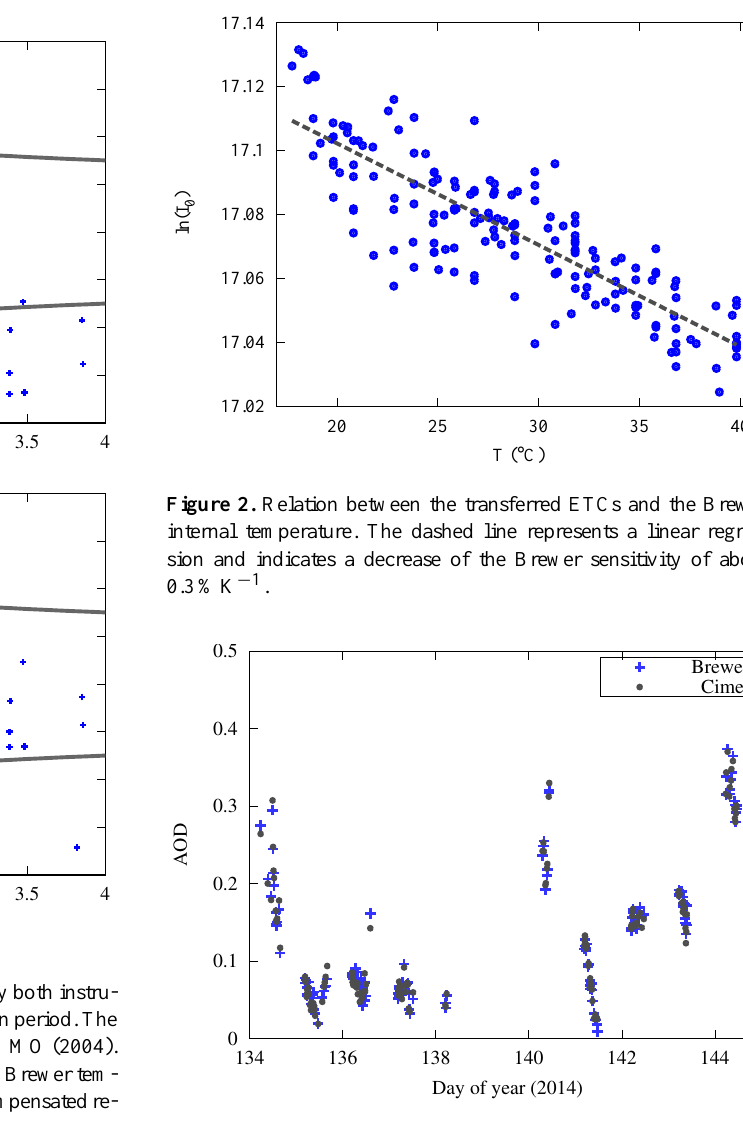
Figure 3. AOD at 437nm (slit 3 of the Brewer) measured by the Brewer (crosses) and the Cimel (dots). Only near-simultaneous measurements are plotted. The Brewer estimates are corrected for the effect of the instrument temperature as explained in Sect.